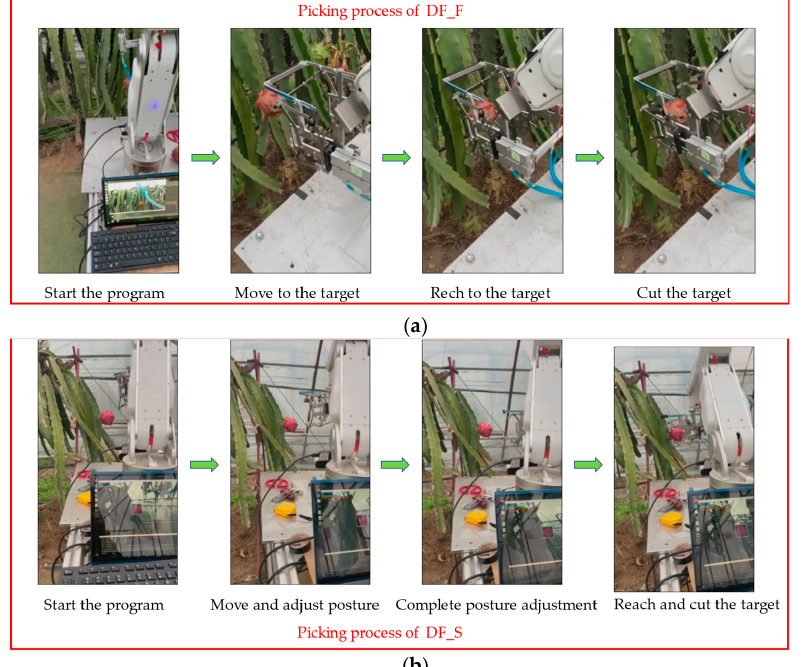
Figure 10. Picking process of the two categories of dragon fruit. ( a ) Picking process of DF_F; ( b ) picking process of DF_S.